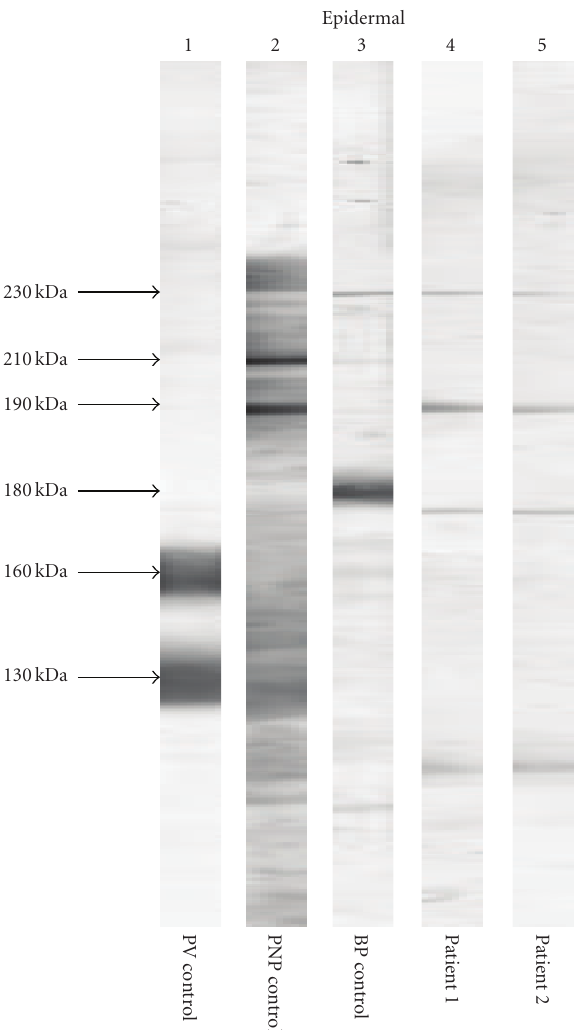
Figure 8: Results of immunoblot analysis using epidermal extract. Patient’s sera taken on 2 di ff erent occasions (lanes 4 and 5, the time interval was 26 days) recognized BP230 and 190 kDa periplakin, which were also detected by control bullous pemphigoid and control PNP sera. No reaction with 210kDa envoplakin was observed. Lane 1: pemphigus vulgaris control serum, Lane 2: PNP control serum, and Lane 3: bullous pemphigoid control serum. The serum dilution was 1:20.